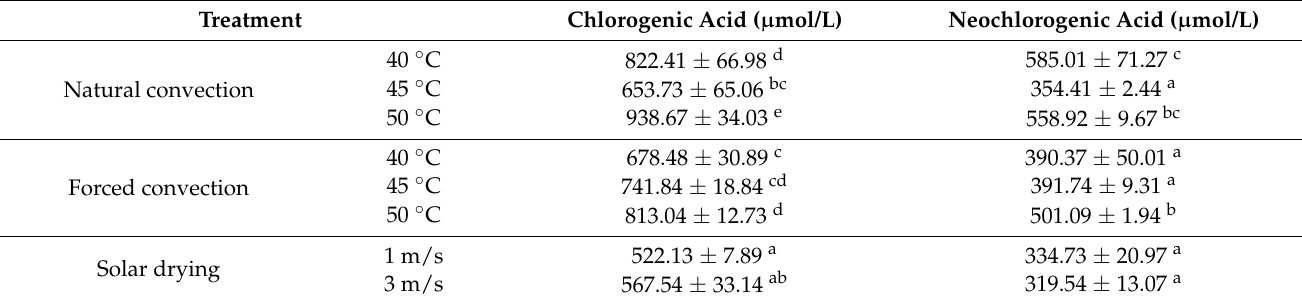
Figure 5. Mass chromatogram obtained from the control sample of the identification analysis per- formed by UPLC-PDA-MS/MS. Table 4. Chlorogenic and neochlorogenic acids content of extracts obtained from dried samples of peach slices obtained at di ff erent temperatures of natural and forced convection.